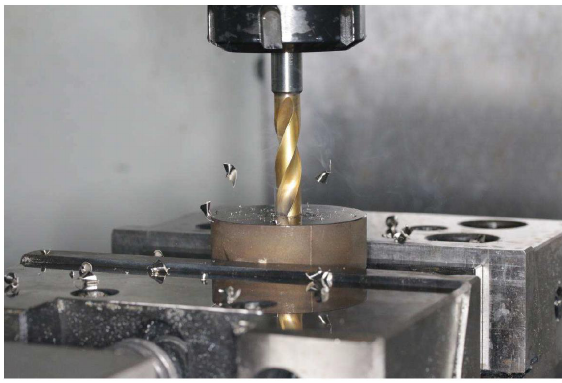
Figure 3. Experimental setup during the dry drilling tests.